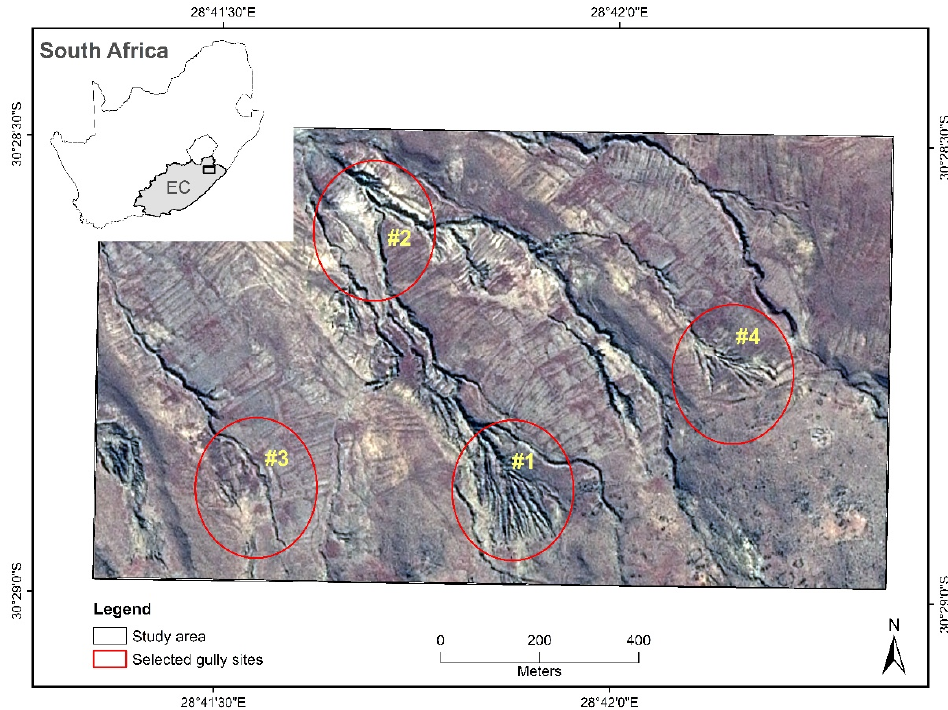
Figure 1. Location of study area, Eastern Cape (EC), South Africa. Selected gully sites (#1–#4).